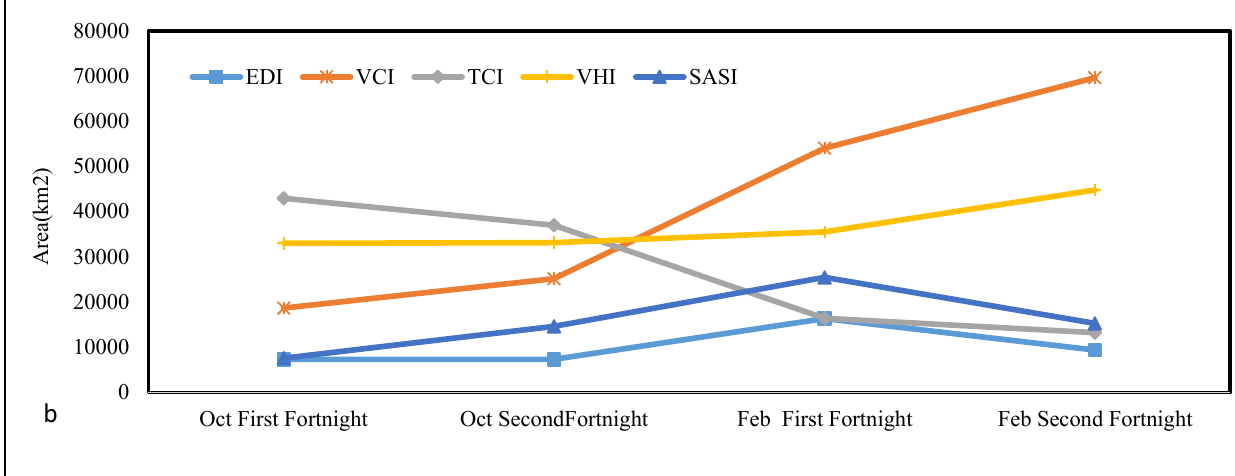
Figure 15.Area under drought as observed by different indices for year (a) 2002, and (b)